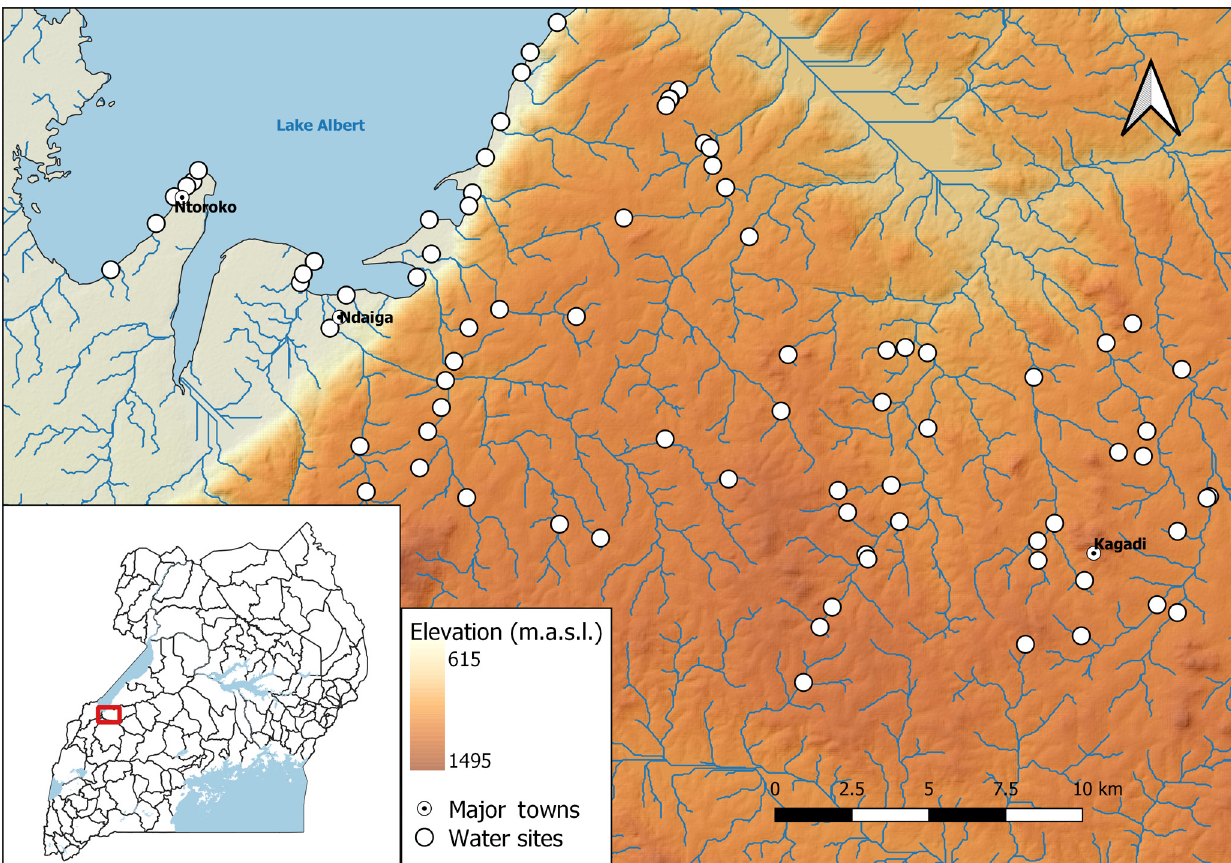
Figure 1 Overview map of the study area showing the selected water contact sites around the southern part of Lake Albert and upstream catchments. (Elevation data: Shuttle Radar Topography Mission (SRTM) downloaded from NASA’s Earthdata Search, river network was extracted from the Digital Elevation